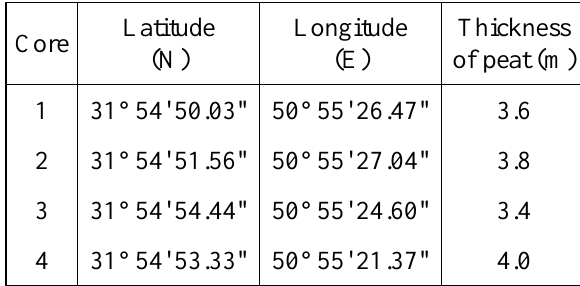
Table 1. Chaghakhor peat sampling locations and